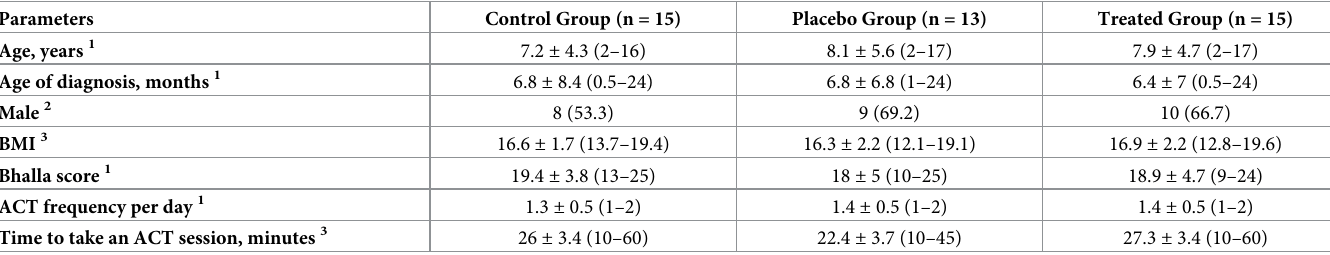
Table 2. Demographic and clinical data and baseline ACT